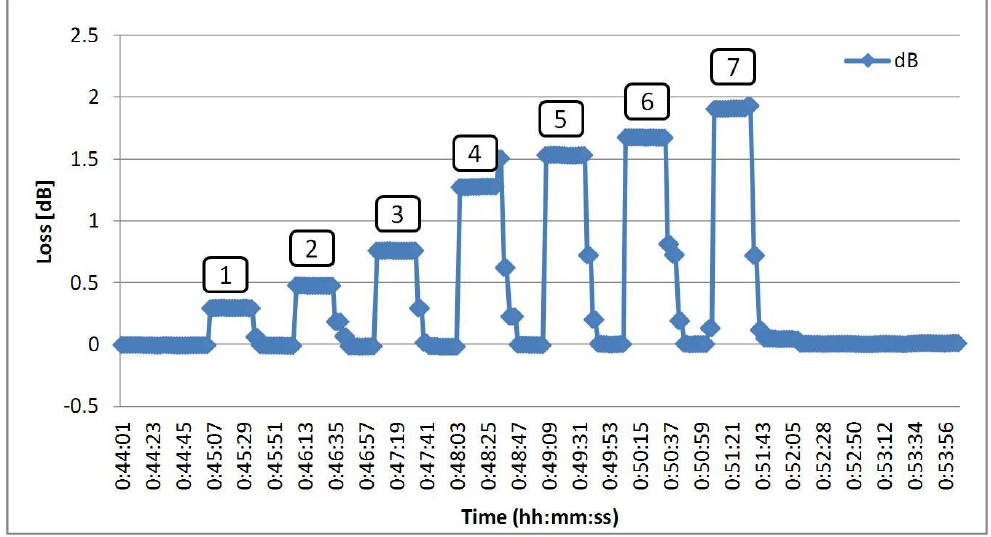
Figure 4. The loss value of sensors measured using